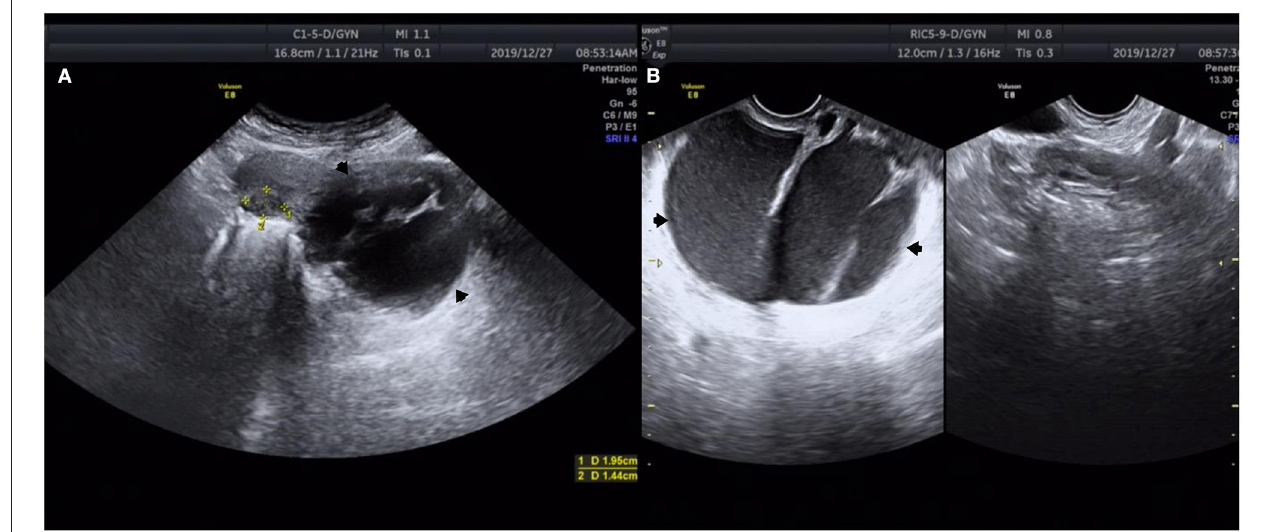
FIGURE 1 | Ultrasound images of a 37-year-old woman with cervical adenocarcinoma. (A) Transabdominal ultrasound shows a 95 × 80mm cyst below the back of the uterine cervix (black arrow). (B) Transvaginal ultrasound shows that the cyst fluid was viscous and there was a large separation in the cyst (black arrow). *Measurement of uterine leiomyoma